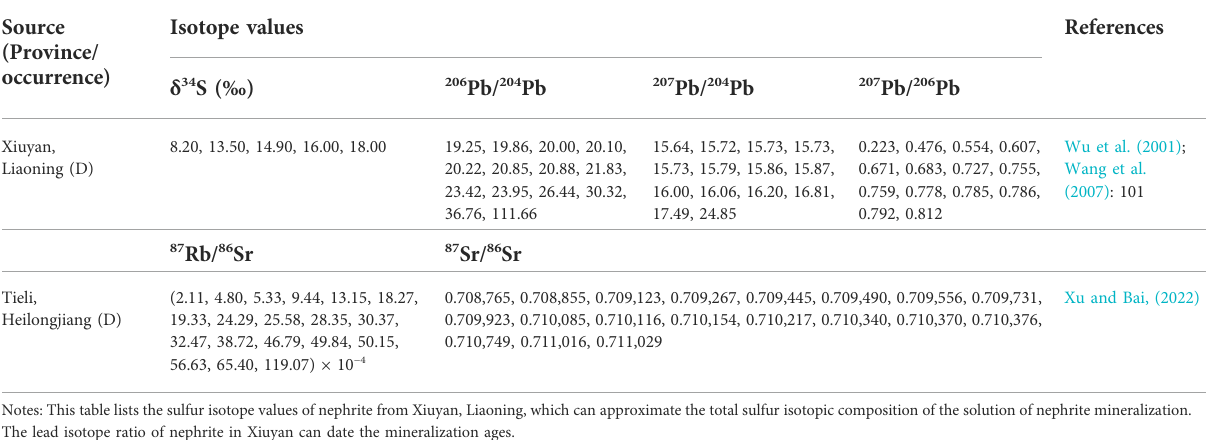
TABLE 3 Sulfur, lead and strontium isotopic values of nephrite